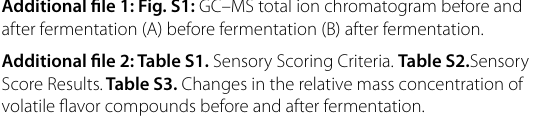
Additional file 2: Table S1. Sensory Scoring Criteria. Table S2. Sensory Score Results. Table S3. Changes in the relative mass concentration of volatile flavor compounds before and after